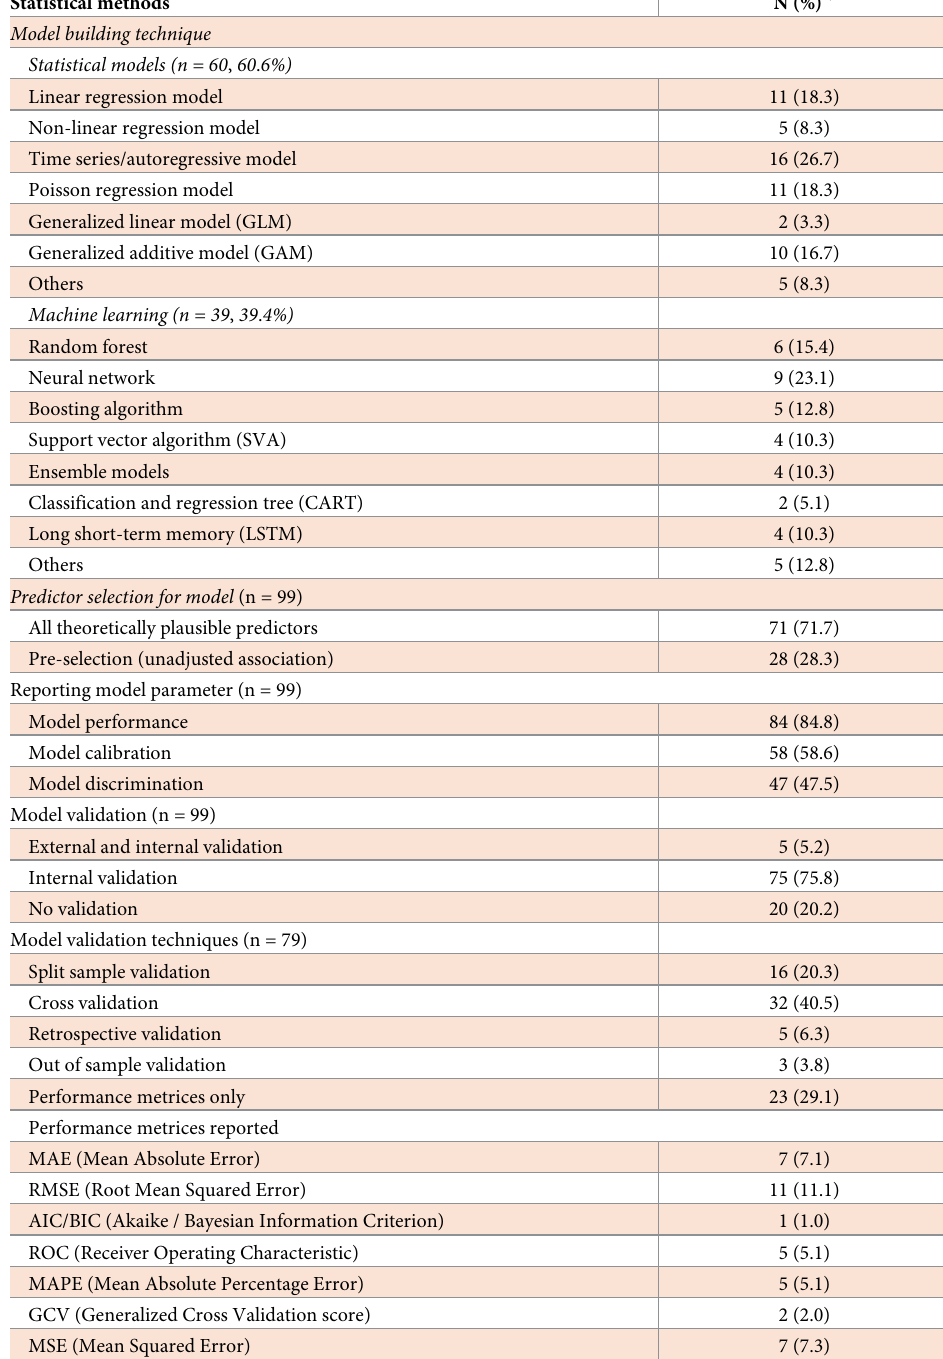
Table 3. Statistical methods used among models (n =